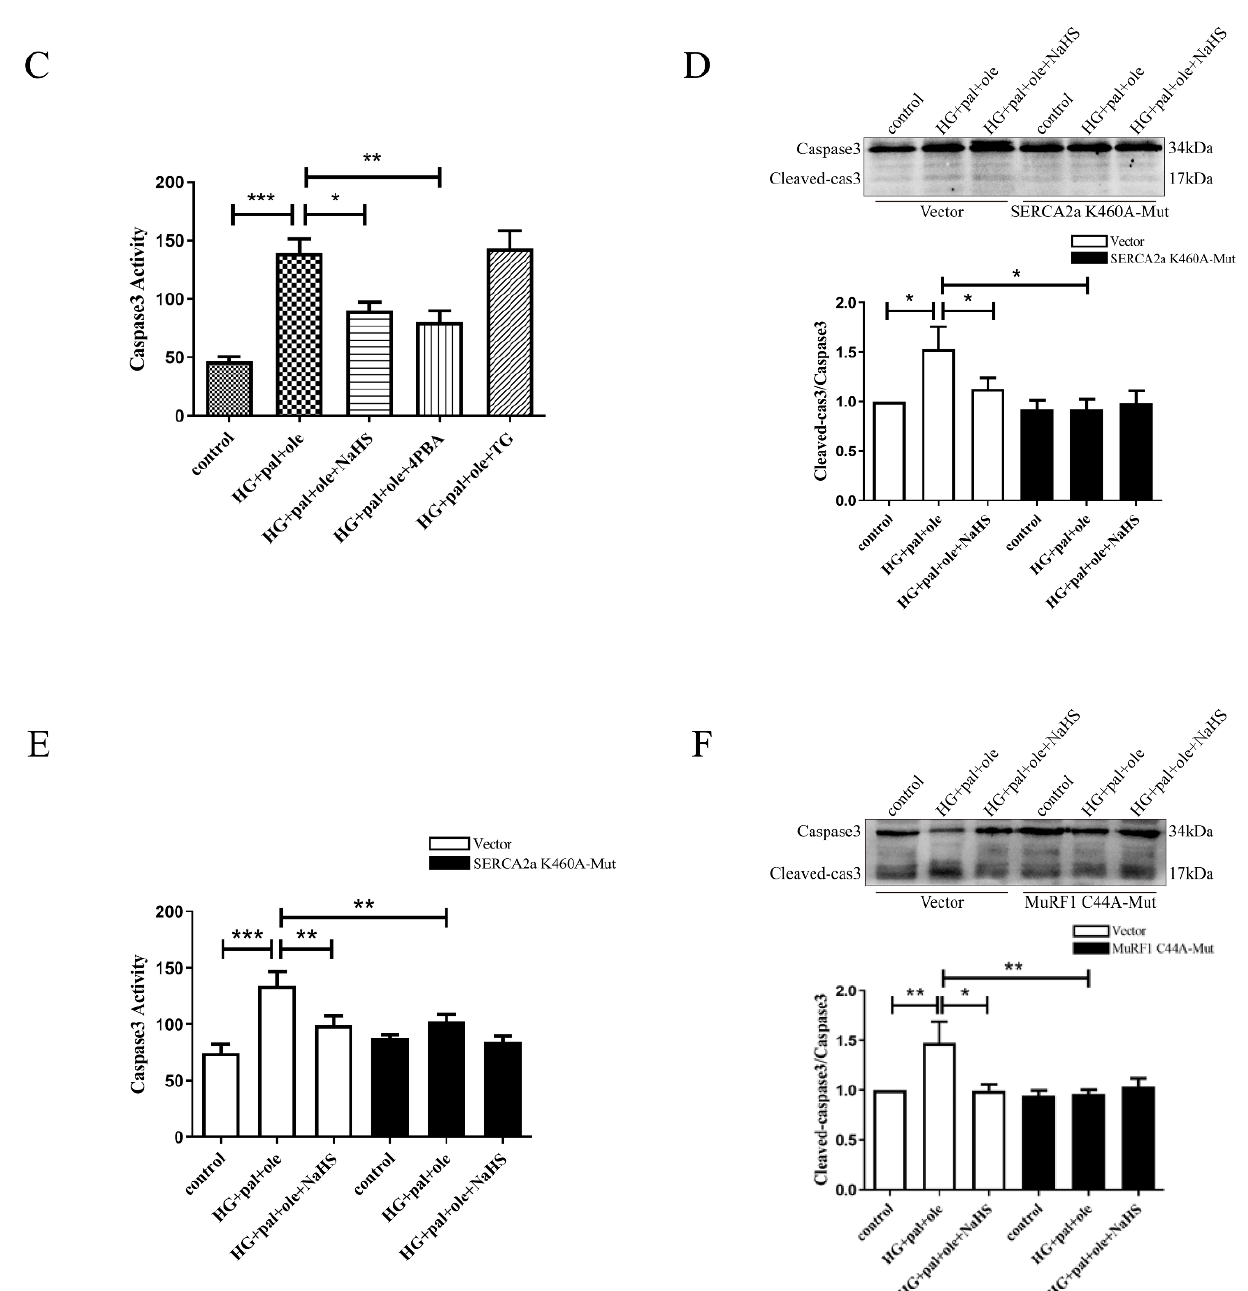
Figure 7. Mutation of SERCA2a Lys460 site reduces the level of apoptosis. ( A ) The expression of apoptotic marker cleave-caspase3 in cardiac tissues was tested by Western blotting ( n = 7). ( B ) The expression of cleave-caspase3 in the NRCMs by Western blotting ( n = 6). ( C ) The activity of Caspase3 in the NRCMs ( n = 4). The NRCMs were transfected with plasmids containing wild-type SERCA2a or SERCA2a mutated at Lys460. ( D ) The expression of cleave-caspase3 in the NRCMs by Western blotting after transfection ( n = 7). ( E ) The activity of Caspase3 in the NRCMs after transfection ( n = 6). Transfection with plasmids containing wild-type MuRF1 or MuRF1 mutated at Cys44. ( F ) The expression of cleave-caspase3 in the NRCMs by Western blotting after transfection ( n = 7). All values are presented as means ± standard errors, * p < 0.05, ** p < 0.01, *** p <